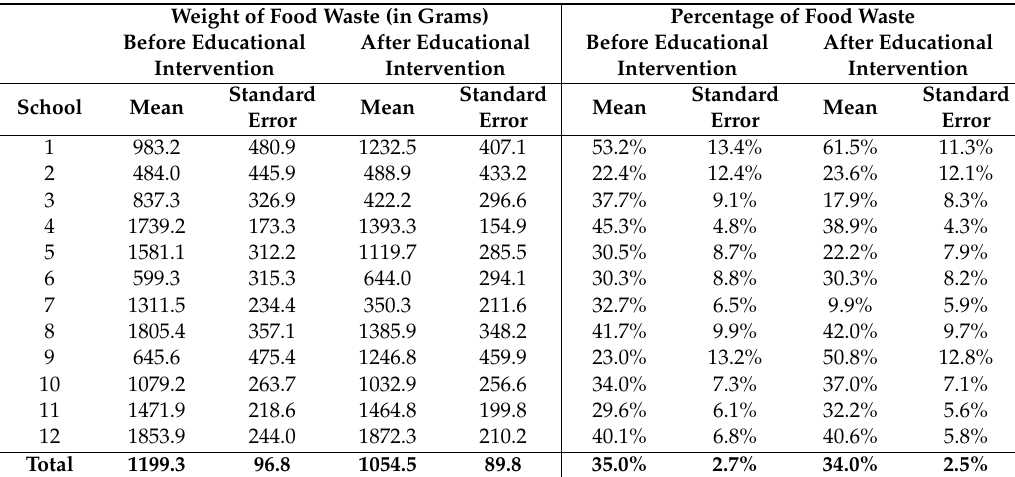
Table 1. Weights and percentages of students’ food waste from the first course before and after educational intervention. No statistically significant di ff erences were found between the 2 time points or between schools.